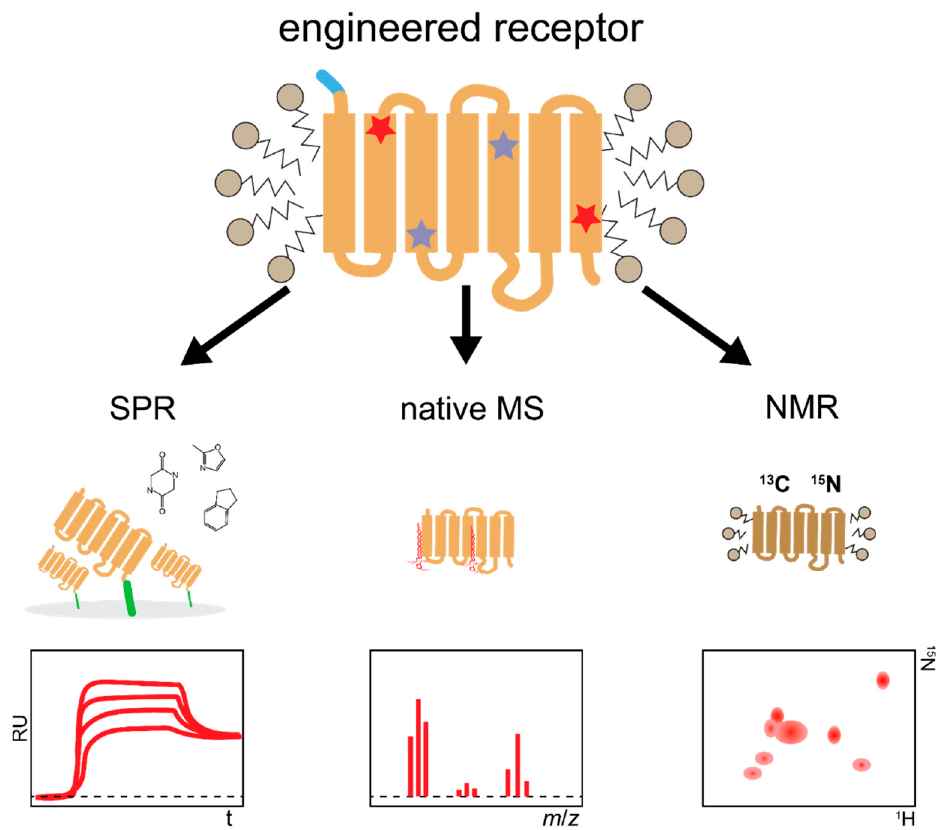
Figure 8. Applications of engineered receptors outside crystallography. Possible applications of receptor variants engineered for stability and enhanced functional expression. Thermostabilized receptors are well suited for methods requiring long half-life in detergent such as surface plasmon resonance (SPR) or nuclear magnetic resonance (NMR). Schematically, mutations introduced are indicated by red and purple stars. Purification tag fused to the receptors is depicted in light blue.